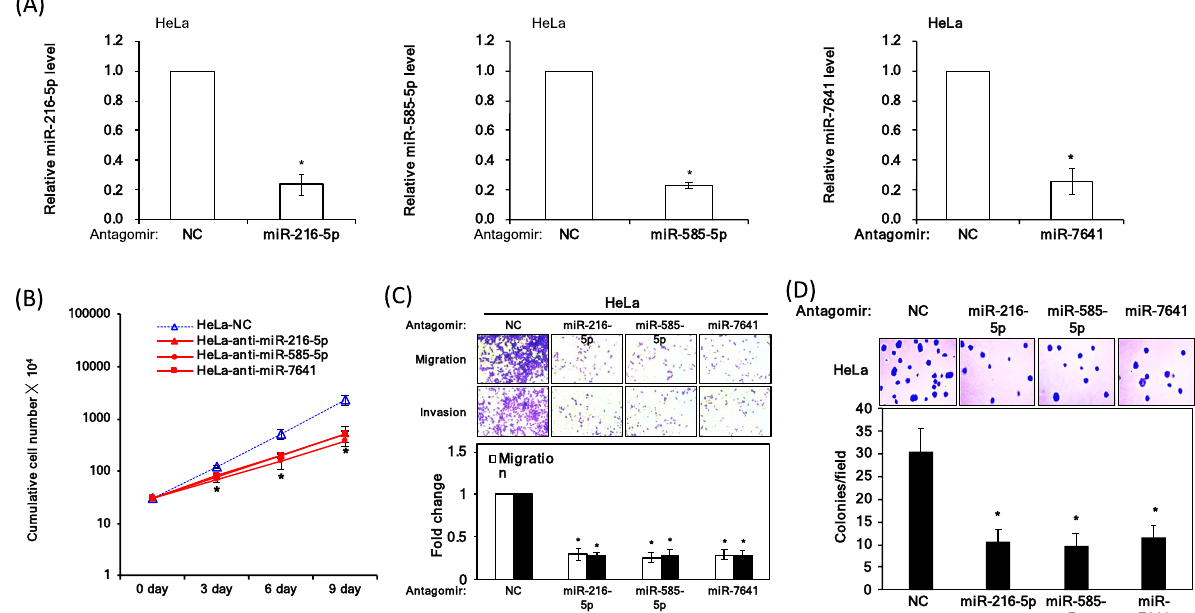
Figure 5. Overexpression of antagomiRs abolished the growth and tumor progression of HeLa cells in vitro. (A) AntagomiR qRT-PCR analysis results. (B) Cell growth assay results. (C) Soft-agar colony formation assay results. (D) Migration and invasion assay